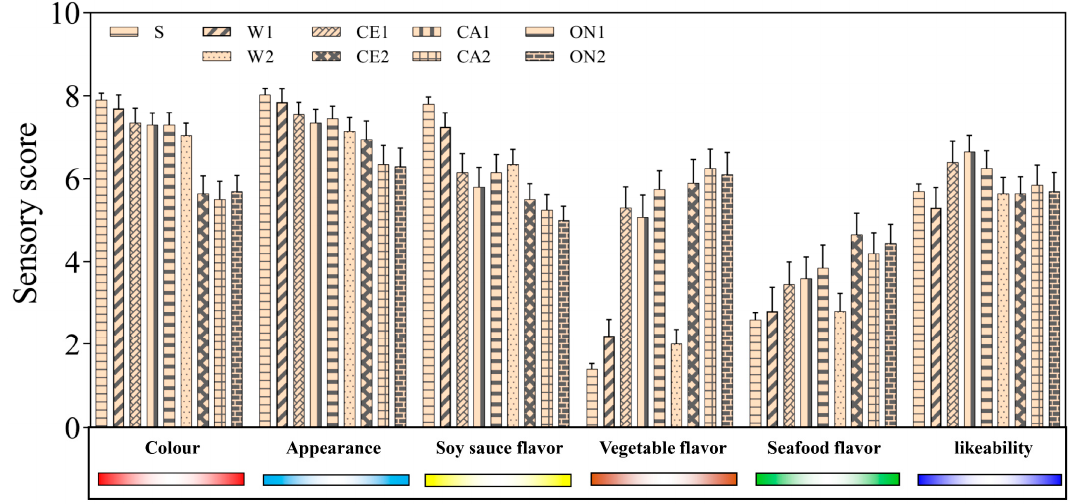
Figure 4. Sensory evaluation results of soy sauce with di ff erent formulations.